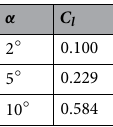
Table 3. CFD results at 2